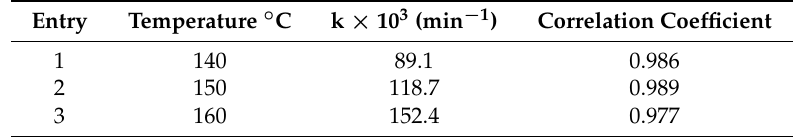
Table 1. Reaction rate constants (k) of glucose dehydration at various reaction temperatures a . Entry